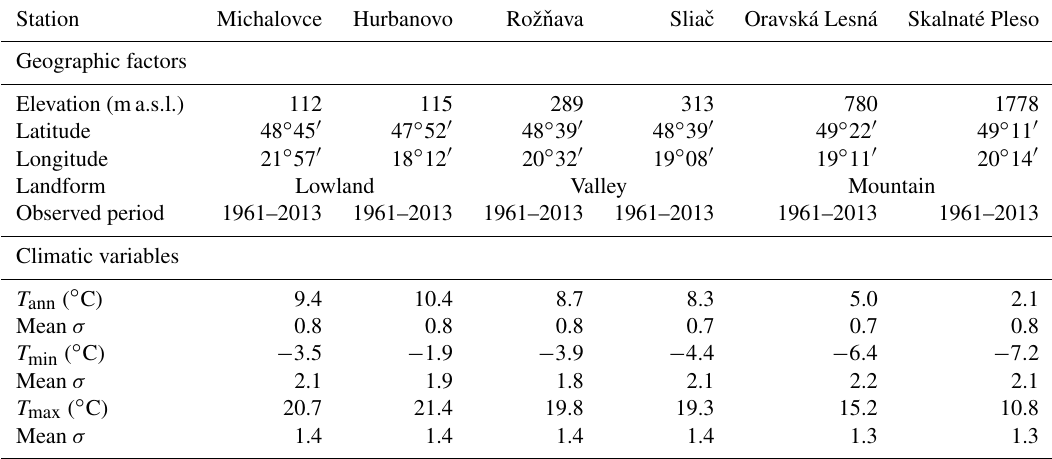
Table 1. Main characteristics of meteorological stations and temperature variables: annual mean temperature ( T ann ), monthly mean temper- atures of the coldest ( T min ) and warmest month ( T max ) in degrees Celsius; σ is standard deviation. Station Michalovce Hurbanovo Rožˇnava Sliaˇc Oravská Lesná Skalnaté Pleso Geographic factors Elevation (ma.s.l.) 112 115 289 313 780 1778 Latitude 48 ◦ 45 (cid:48) 47 ◦ 52 (cid:48) 48 ◦ 39 (cid:48) 48 ◦ 39 (cid:48) 49 ◦ 22 (cid:48) 49 ◦ 11 (cid:48) Longitude 21 ◦ 57 (cid:48) 18 ◦ 12 (cid:48) 20 ◦ 32 (cid:48) 19 ◦ 08 (cid:48) 19 ◦ 11 (cid:48) 20 ◦ 14 (cid:48) Landform Lowland Valley Mountain Observed period 1961–2013 Climatic variables T ann ( ◦ C) Mean σ 0.8 0.8 T min ( ◦ C) Mean